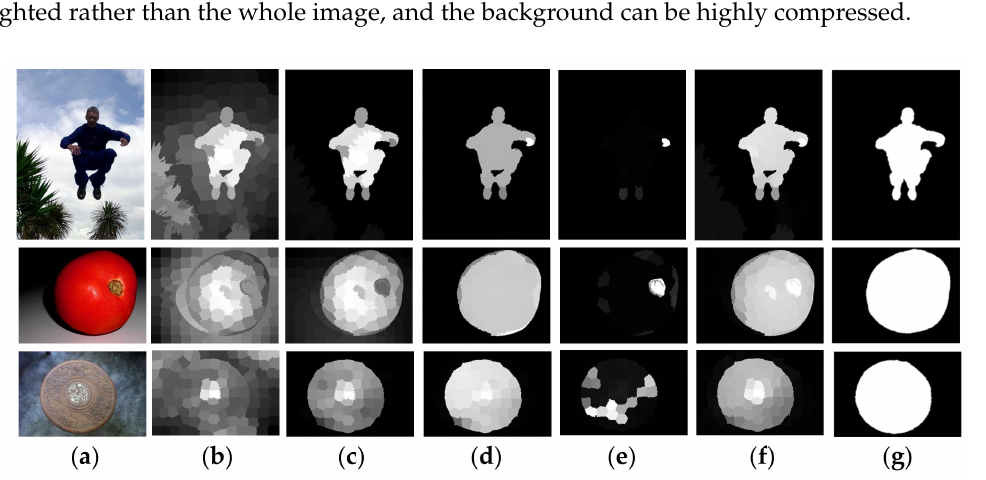
Figure 7. Visual comparisons of global contrast-based method and our proposed uniqueness-based method. ( a ) Original images. ( b ) Saliency maps based on global contrast-based cue. ( c ) Our